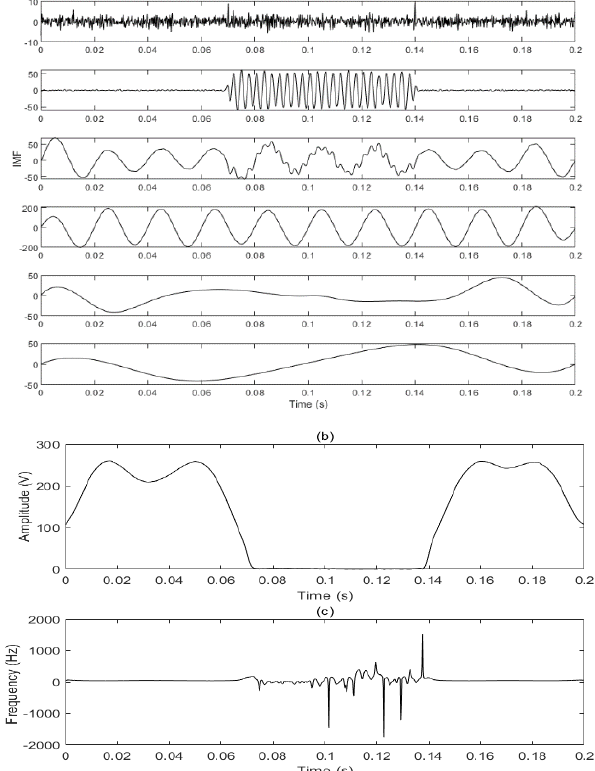
Figure 11. Voltage interruption IMF components ( a ), amplitude ( b ), and frequency ( c ).